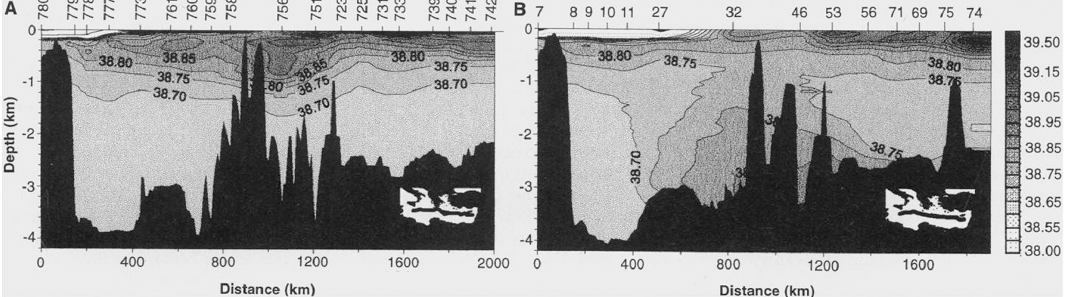
Fig. 7. Salinity isolines on sections across the Ionian Basin (see inset maps) for Meteor cruises M5/6 (1987) (A) and M31/1 (1995) (B) – stations are at the